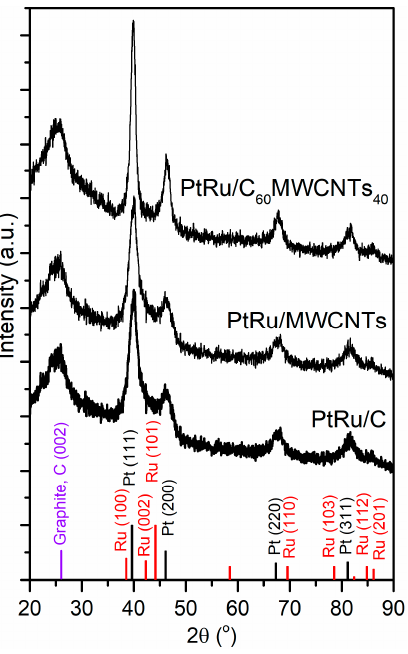
Figure 1. XRD patterns of PtRu/C, PtRu/MWCNTs, and PtRu/C 60 MWCNTs 40